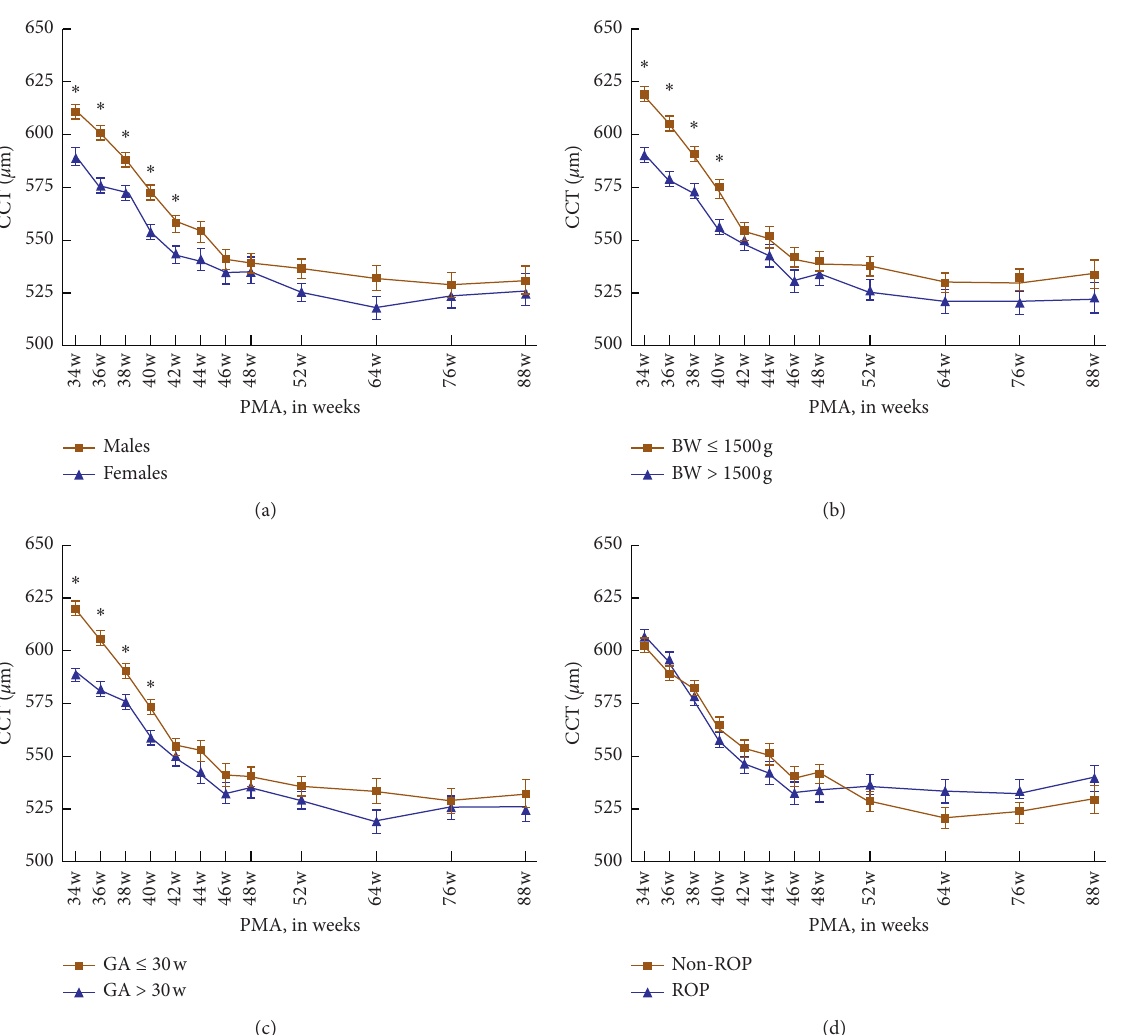
Figure 2: (a) Mean CCTof different genders at each week of PMA; (b) mean CCTof different BWs at each PMA; (c) mean CCTof different GAs at each PMA; (d) mean CCT in the ROP subgroup and without the ROP subgroup at different PMAs. ∗ P < 0 .